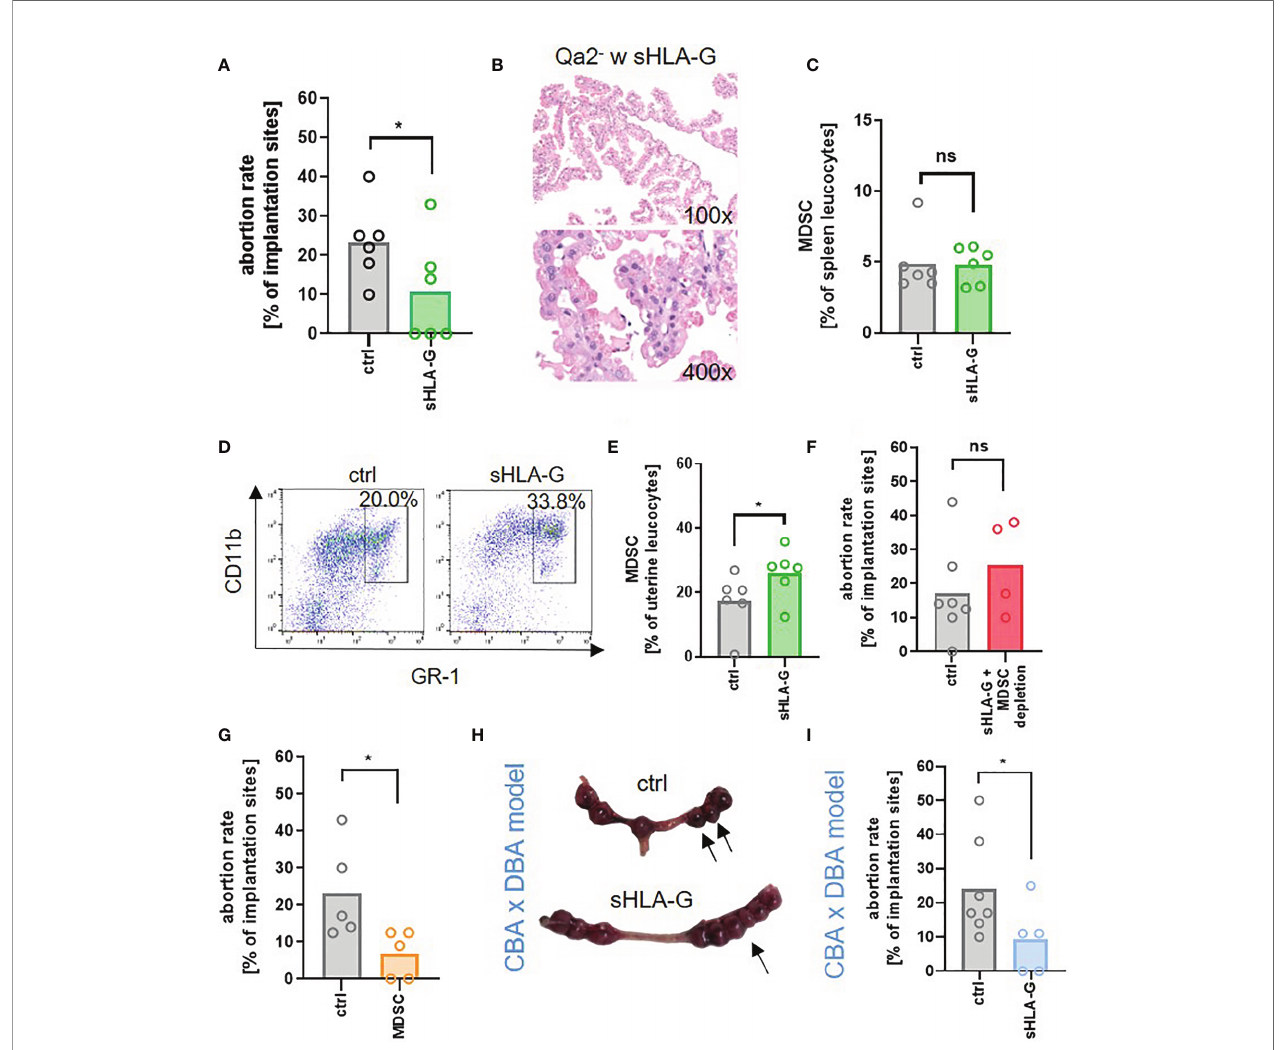
FIGURE 5 | sHLA-G improves pregnancy outcome. (A – F) Qa-2de fi cient mice (Qa2 - ) were term-bred andthe day whena vaginalplug was detectedwas de fi ned as dayE0.5. At E10.5 and E14.5 mice receivedeither PBS, 1µg/g bodyweightsHLA-G or 1µg/g bodyweightsHLA-G andanti-Ly6G-antibody. (A) Abortion rate (percentage of resorbed fetuses per litter) of Qa-2 - miceafter applicationof PBS (ctrl, n=6) or sHLA-G (n=6) at E18.5. (B) Representative images of H&E stainedchorionic villi Qa-2 - animals that received sHLA-G. (C) Percentages ofMDSC in spleens of pregnant Qa-2- animals after application of PBS (ctrl, n=6) or sHLA-G (n=6) at E18.5. (D) Representative pseudocolor plots for Gr-1 versus CD11bshowing the population of MDSC in uterus leucocytes of Qa-2 - mice after applicationofPBS or sHLA-G inthe upper right quadrant. Cells were pre-gated onCD45. (E) Percentages of MDSC inuteri of pregnant Qa-2 - animals after applicationof PBS (ctrl, n=6) or sHLA-G (n=6) at E18.5. (F) Abortionrate ofQa-2 de fi cient miceafter applicationof PBS (ctrl, n=7) or sHLA-G and anti-Ly6G-antibody(n=4) at E18.5. (G+H) Female CBA/Jmice were term-bredwith male DBA/2J mice and the daywhena vaginal plug was detected was de fi nedas day E0.5. At E0.5, E3.5, E6.5 and E9.5 mice received either PBS or 1µg/g bodyweightsHLA-G. (G) Abortionrate ofQa-2 de fi cient miceafter applicationof PBS (ctrl, n=5) or MDSC (n=5) at E18.5. (H+I) Female CBA/J mice were term-bredwith male DBA/2J mice andthe daywhena vaginalplug was detectedwas de fi nedas dayE0.5. At E0.5, E3.5, E6.5 andE9.5 mice receivedeither PBS or 1ug/g bodyweight sHLA-G. (H) Representative uteri containing fetal-placentalunits from PBS (ctrl, n=7) andsHLA-G treated mice (n=5) atgestational dayE10.5. Arrows show resorbed fetuses. (I) Abortion rate of CBA/J mice after applicationof PBS (ctrl, n=7) or sHLA-G (n=5) atE10.5. Each symbolrepresents anindividualanimal and themeanis indicated. *p < 0.05; ns, not signi fi cant. Mann-Whitney